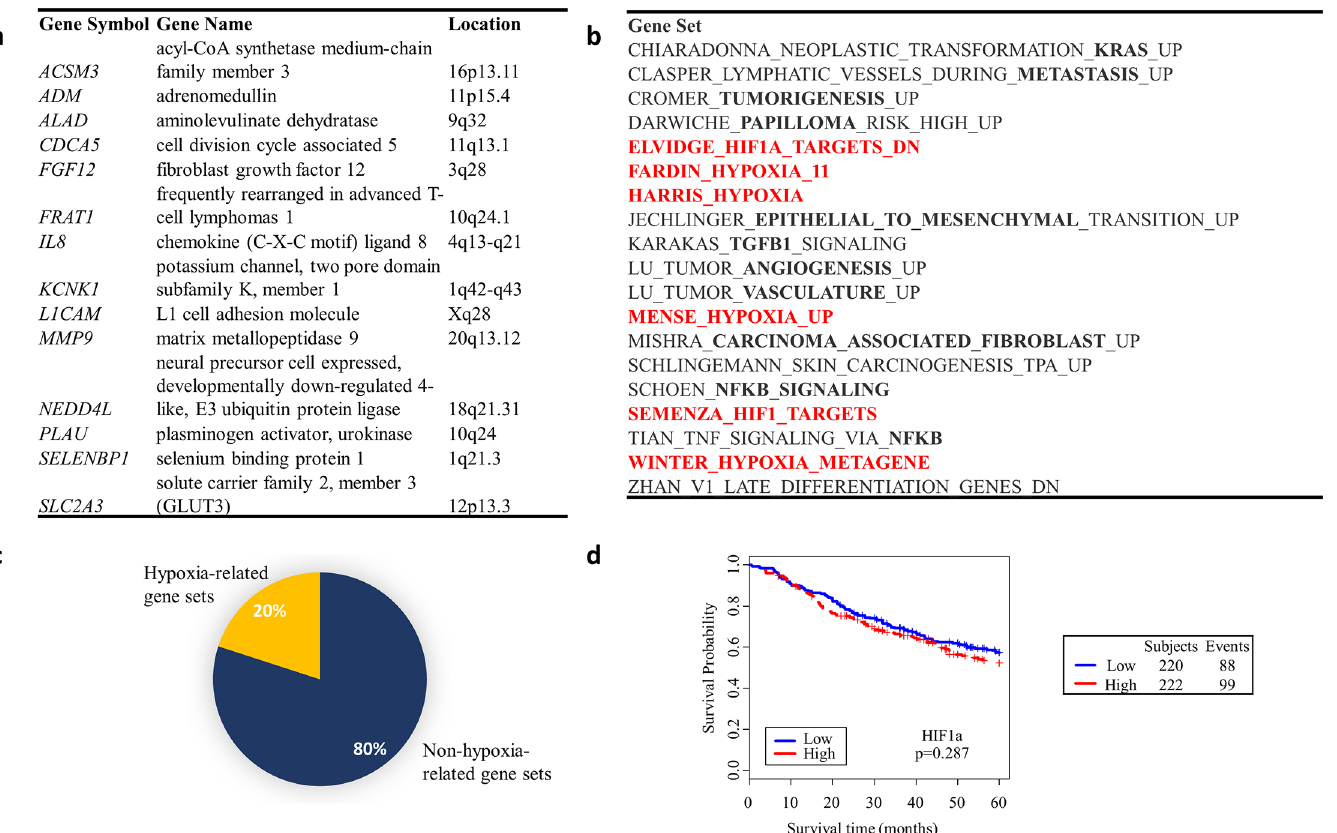
Fig 2. Validated radiogenomic abnormalities in two cohorts of patients with early-stage NSCLC. (a) The most significantly enriched genes in PET-intense tumors (p < 0.05, fold change > 2.0) were selected from the study and PET validation cohort. Selected genes that overlapped are displayed in the table. (b) Average rank-based GSEA results for all pathways in the MSigDB database that were enriched in high-intensity tumors in both the study and PET validation cohorts and (c) quantified relative to hypoxia. (d) Kaplan-Meier survivor curves and log-rank test of HIF1A expression in prognostic validation cohort (N = 442) using median gene expression as cutoff to divide low and high